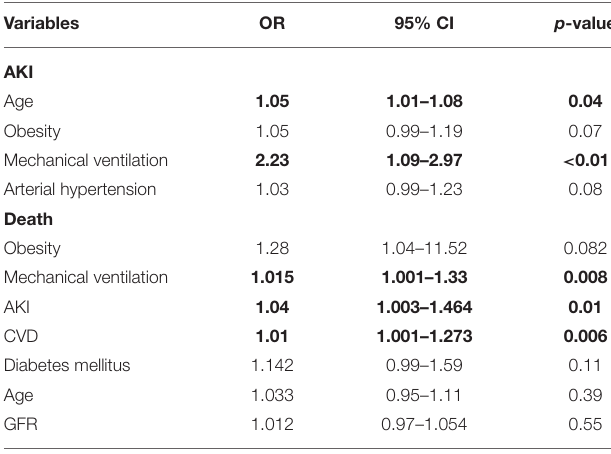
CI, confidence interval; AKI, acute kidney injury; CVD, cardiovascular disease; GFR, glomerular filtration rate (CKD-EPI). Bold values refer to variables that had a p-value less than 0.05.